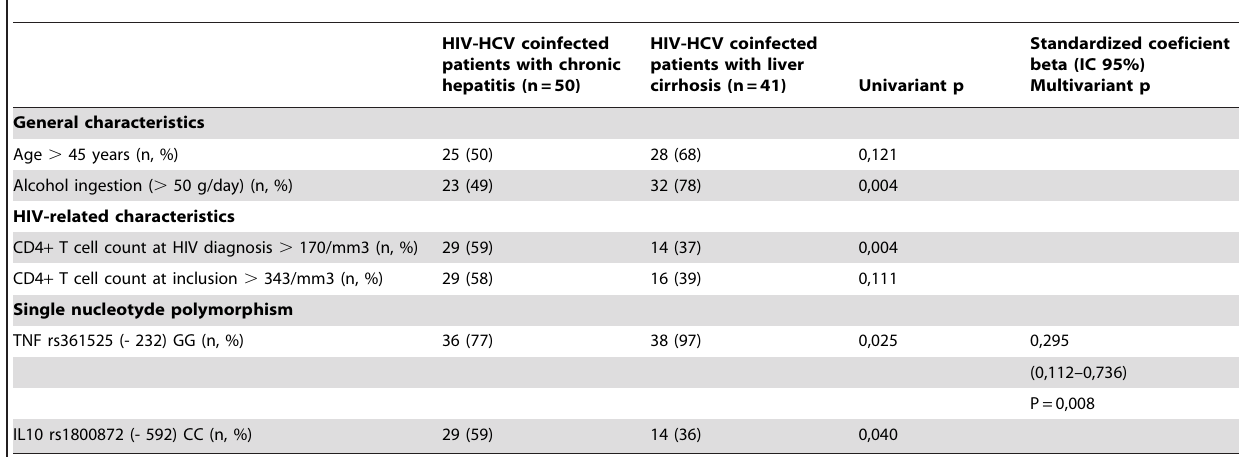
Table 5. Multivariant analysis of factors associated with the development of liver cirrhosis in HIV-HCV coinfected patients.